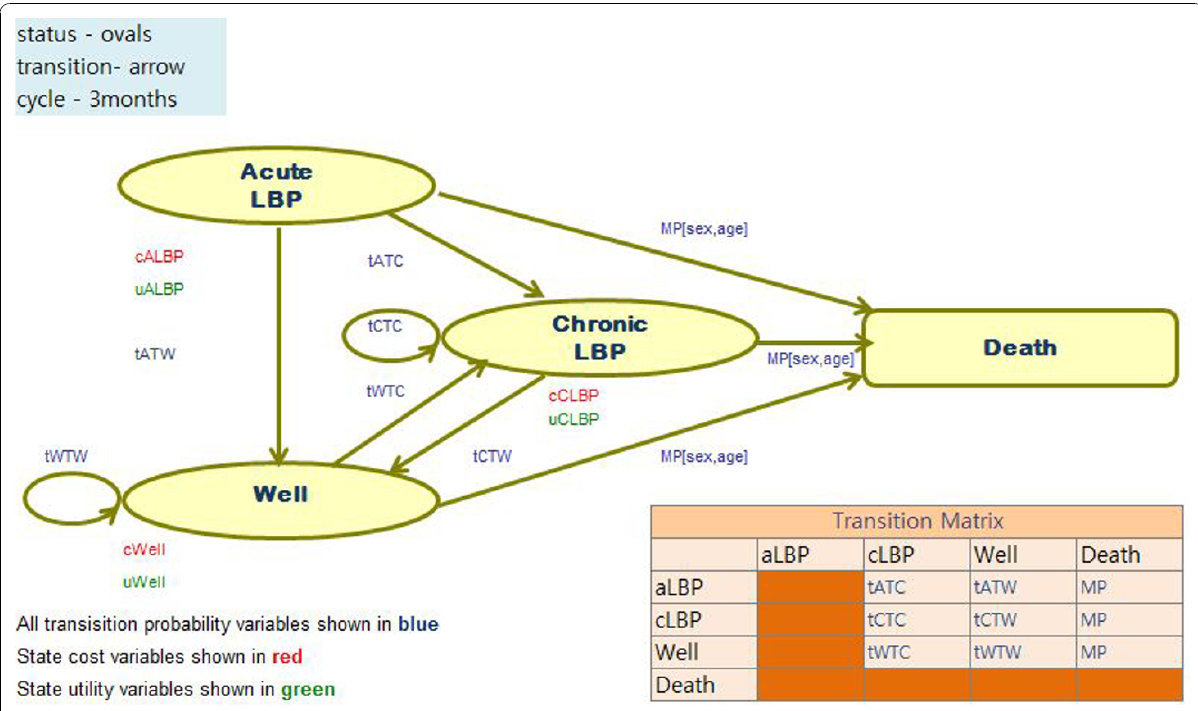
Figure 1 Markov model of chronic low back pain